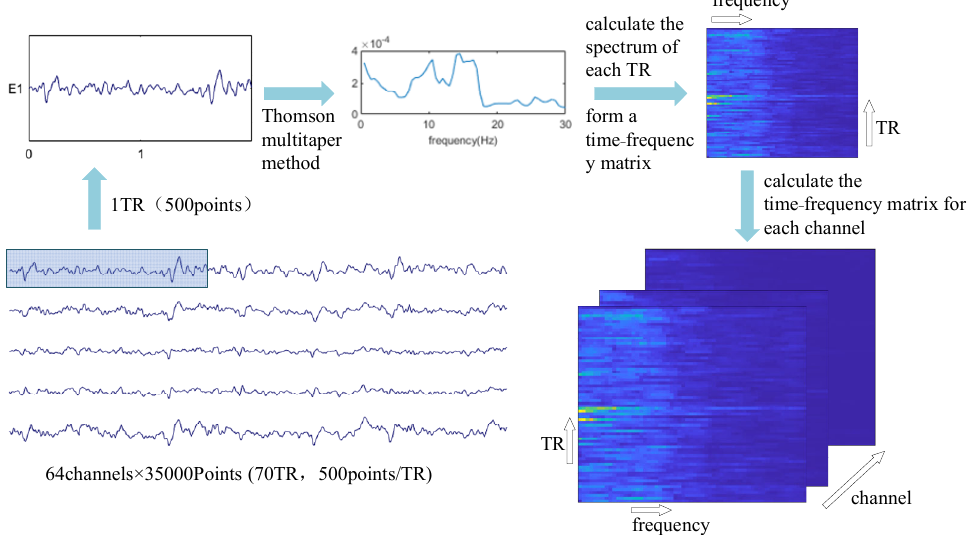
Figure 3. A tensorization strategy based on time ‐ frequency transformation was used to convert the EEG data into a third ‐ order tensor (time points × frequencies × channels). A spectrogram for each segment (length equal to the repetition time of the fMRI data) of each channel was calculated as the third dimension of the EEG data using Thomson’s multitaper method. From 1 Hz to 30 Hz, the squared Fourier amplitudes were averaged into 0.5 Hz bins. Thus, an EEG tensor was obtained and was synchronized in time with the fMRI data.